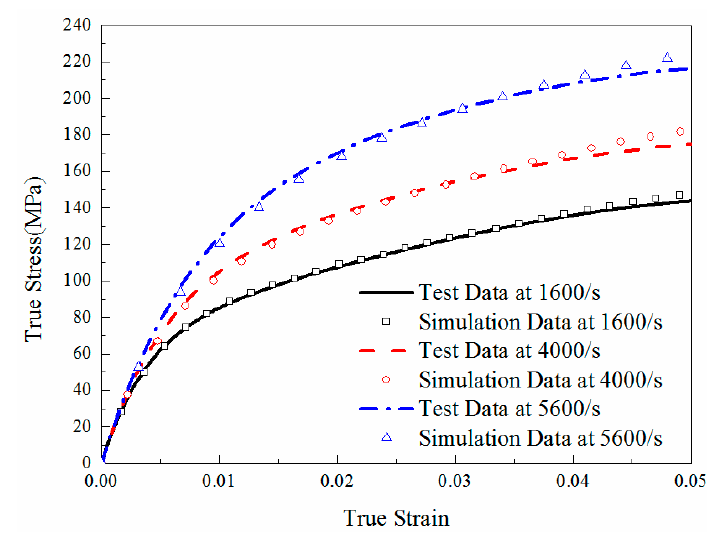
Figure 14. Comparison between simulation and test results of pure epoxy resin.